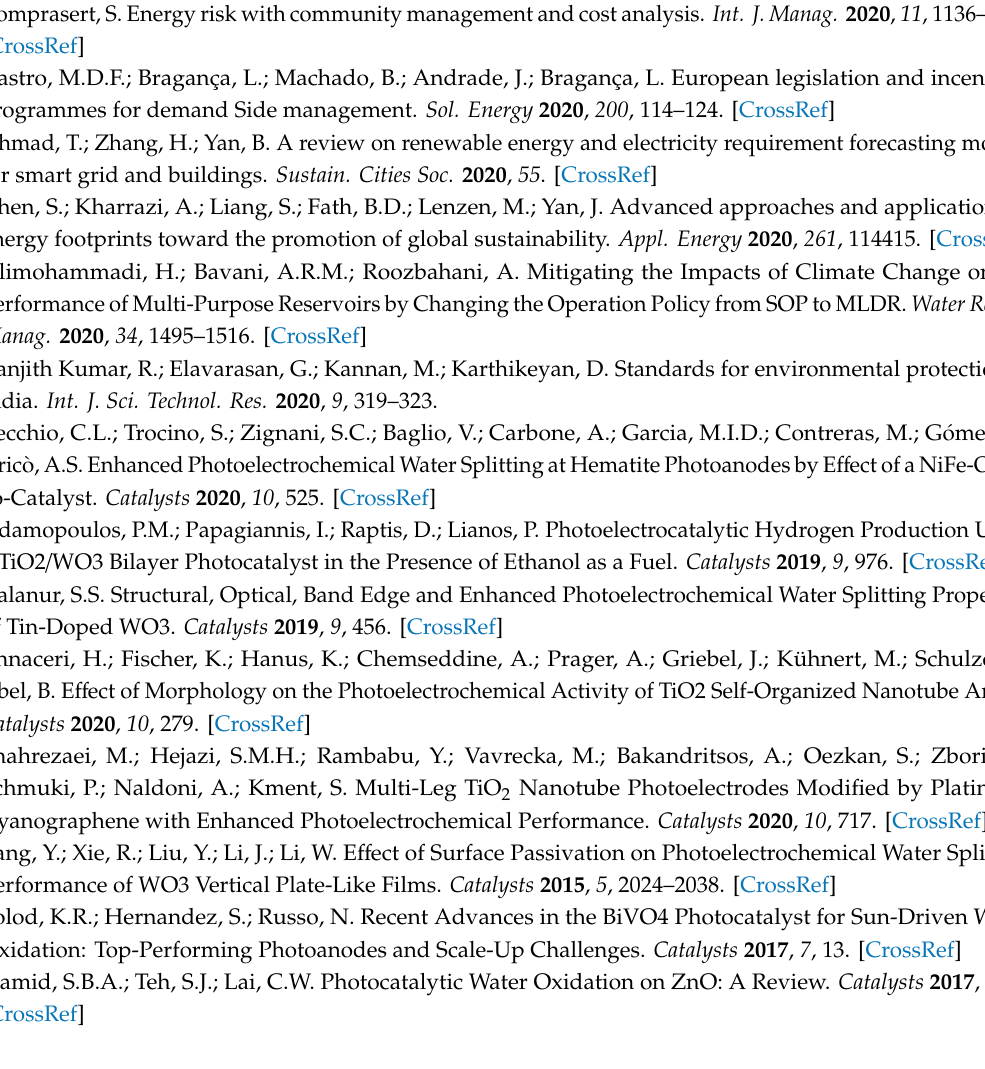
Figure S1: Photos of photocathode substrates Sigracet 35BC ® (on the left) and Sigracet 35BC ® + FEP 7% (on the right) after 0 s (a,b) and after 1800 s (c,d), Figure S2: XRD pattern of synthesised anodic semiconductor Fe 2 O 3 deposited on FTO glass and relative JCPDS cards, Figure S3: XRD pattern of synthesised anodic semiconductor Fe 2 O 3 + NiFeOx deposited on FTO glass and relative JCPDS cards, Figure S4: Photographs of transparent anionic membrane FAA-3 either dry (a) or wet (b), Figure S5: Mass spectrometry analysis during potentiostatic test (applied cell bias of − 0.6 V) of the PEC cell (glass + FTO + Fe 2 O 3 + NiFeOX + ionomer / FAA-3 / ionomer + CuO + Sigracet 35BC ® + FEP7%): H2 ionic current (a) and CO ionic current (b), Figure S6: Schematic sketch (a) and photograph (b) of the photoelectrochemical cell (PEC) with carbonaceous gas di ff usion layer as cathode substrate and filter paper to highlight any traces of water (left); (c) photograph of filter paper “post operation”, Figure S7: Images of a 60 cm water column (about 60 mbar) in a burette placed perpendicular to a CuO / Sigracet 35BC ® + FEP 7% sample at the beginning (a), after 1800 s (b), after 15000 s (c), Figure S8: SEM images of the outer NiFeOx-coated hematite photoanode surface, before (a) and after (b) the durability